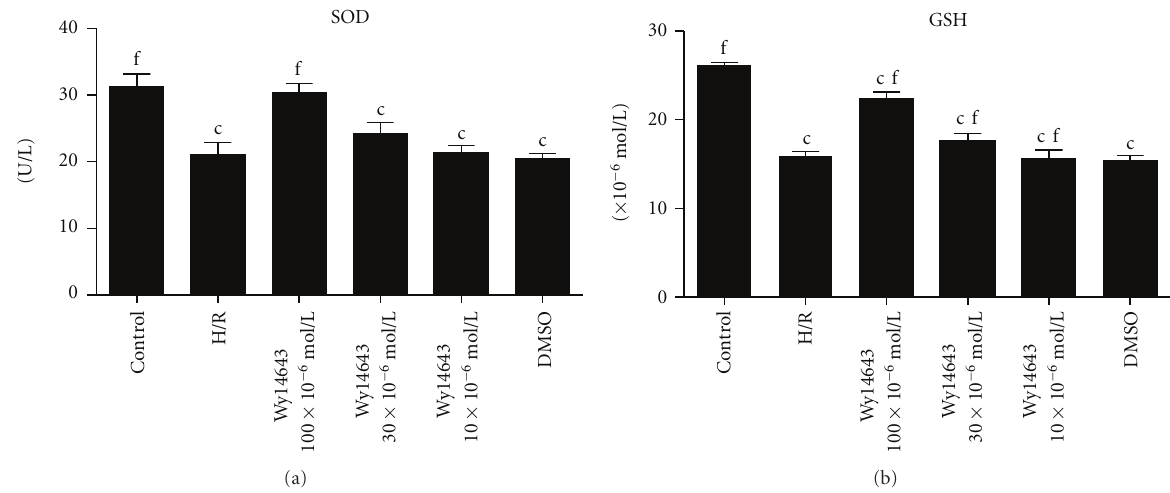
Figure 2: (a) SOD in di ff erent groups (Mean ± SD, n = 6). After 4 h of hepatocellular hypoxia and 10h of reoxygenation. The levels of SOD in hepatocytes determined. c P < 0 . 01 versus control group; f P < 0 . 01 versus H/R group. (b) GSH in di ff erent groups (Mean ± SD, n = 6). After 4 h of hepatocellular hypoxia and 10 h of reoxygenation. The content of GSH in hepatocytes mitochondria fractions was determined. c P < 0 . 01 versus control group; f P < 0 . 01 versus H/R group.